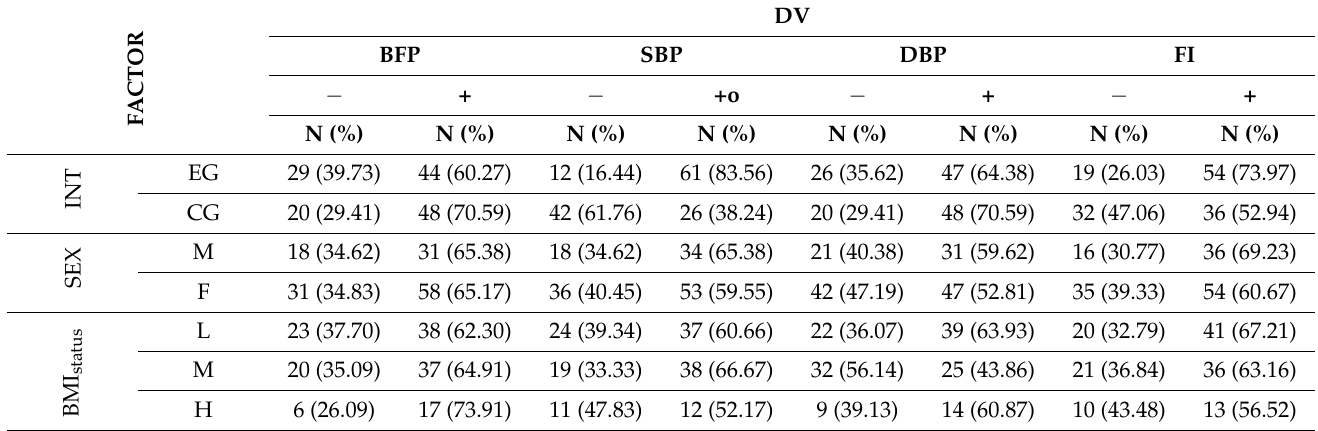
Table 2. Numbers and frequencies of individuals in categories of each factor (INT, SEX, and BMI status ) with positive (+) and no positive ( − ) changes after intervention in measured parameters (BFP, SBP, DBP, and